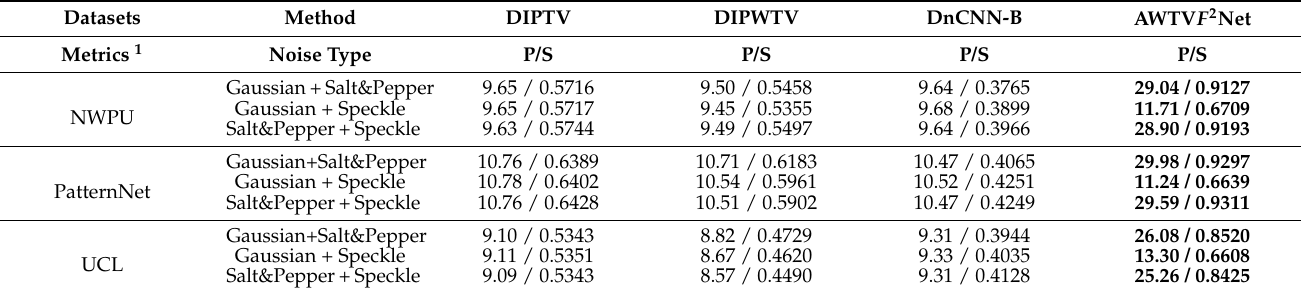
Table 5. Numercial comparisons of different datasets with various types of mixture noise. The bold values denote the best results.